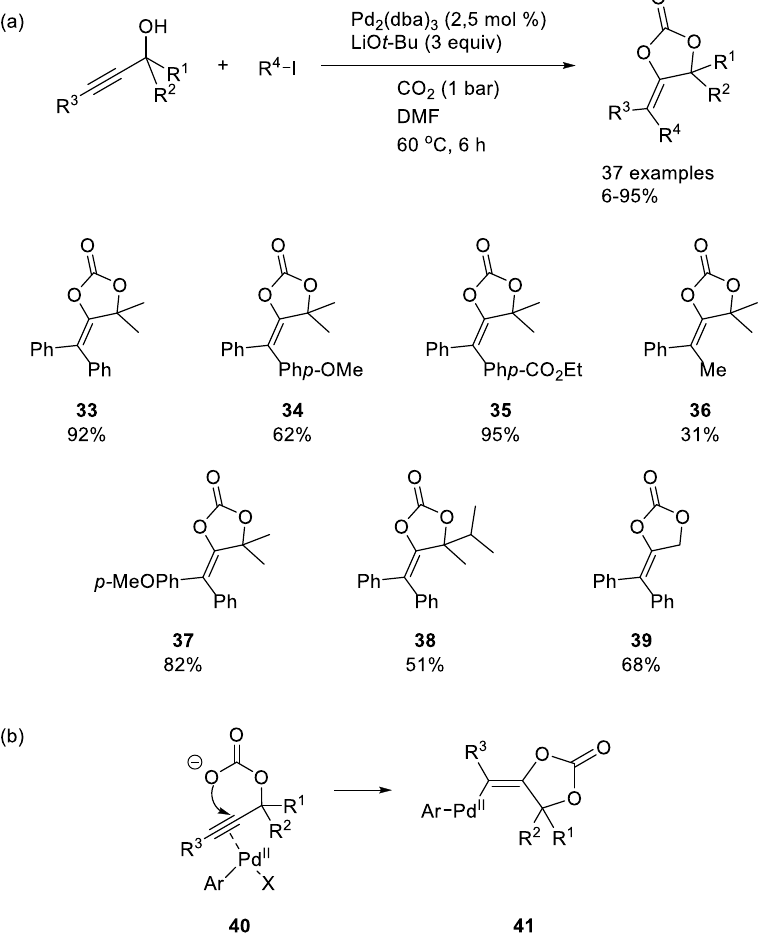
Scheme 8. ( a ) The substrate scope of Cheng’s three component Pd-catalyzed reaction of propargyl alcohols, aryl-iodides, and CO 2 ; ( b ) trans- oxopalladation step in the proposed reaction mechanism [28]. Silver Silver(I)-salts and their complexes have been among the most effective catalysts for the fixation of CO 2 with propargylic alcohols. In 2007, Yamada reported a range of Ag(I)- catalysts for the formation of cyclic carbonates from a variety of terminal and internal propargylic alcohols [29] (Scheme 9a). Some of the desired carbonates were obtained in good yields even under the atmospheric pressure of CO 2 . Interestingly, only Z -alkenes as final products were obtained. In a 2011, the same group reported that symmetric dipro- pargyl alcohols of type 42 underwent an enantioselective reaction, with up to 93% e.e. by employing an Ag complex containing a chiral salen ligand 43 . As expected, sterically bulky substrates had slow kinetics and needed up to 168 h for the full conversion (Scheme 9b) [30].